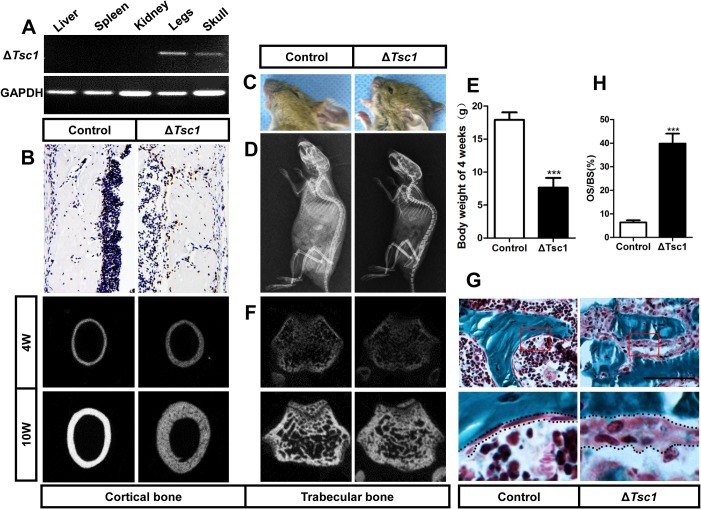
mTORC1 activation in preosteoblasts produces immature woven bone.(A) PCR analysis of Tsc1 allele recombination in tissues from Osx-GFP::Cre
TG/+;Tsc1
flox/flox mice (ΔTsc1 mice). Primers for GAPDH were used as a loading control. (B) Immunohistochemical staining of S6 phosphorylation (Ser235/236) in sections of distal femur from 10-week-old control and ΔTsc1 mice. (C) The 10-week-old ΔTsc1 mouse had a square skull (the result of hyperplasia of the osteoid, a typical manifestation of rickets) compared with the control littermate. (D) Plain X-ray examination of a 4-week-old ΔTsc1 mouse revealed a smaller skeleton and higher bone mass compared with the control littermate. (E) Body weight of 4-week-old control and ΔTsc1 mice. (F) Representative images of micro-CT analyses of the structure of metaphyseal trabecular bone and cortical bone in the distal femur showed increased bone mass, but more porous areas (indicating more hypomineralized areas) in ΔTsc1 mice. (G, H) Goldner’s Masson trichrome staining of distal femur showed more osteoid/hypomineralized areas (stained red) in bone of ΔTsc1 mice. Boxed area is enlarged in the panel below. The dotted line marked boundary of the red osteoid. OS/BS, osteoid per bone surface. Scale bar, 100μm.